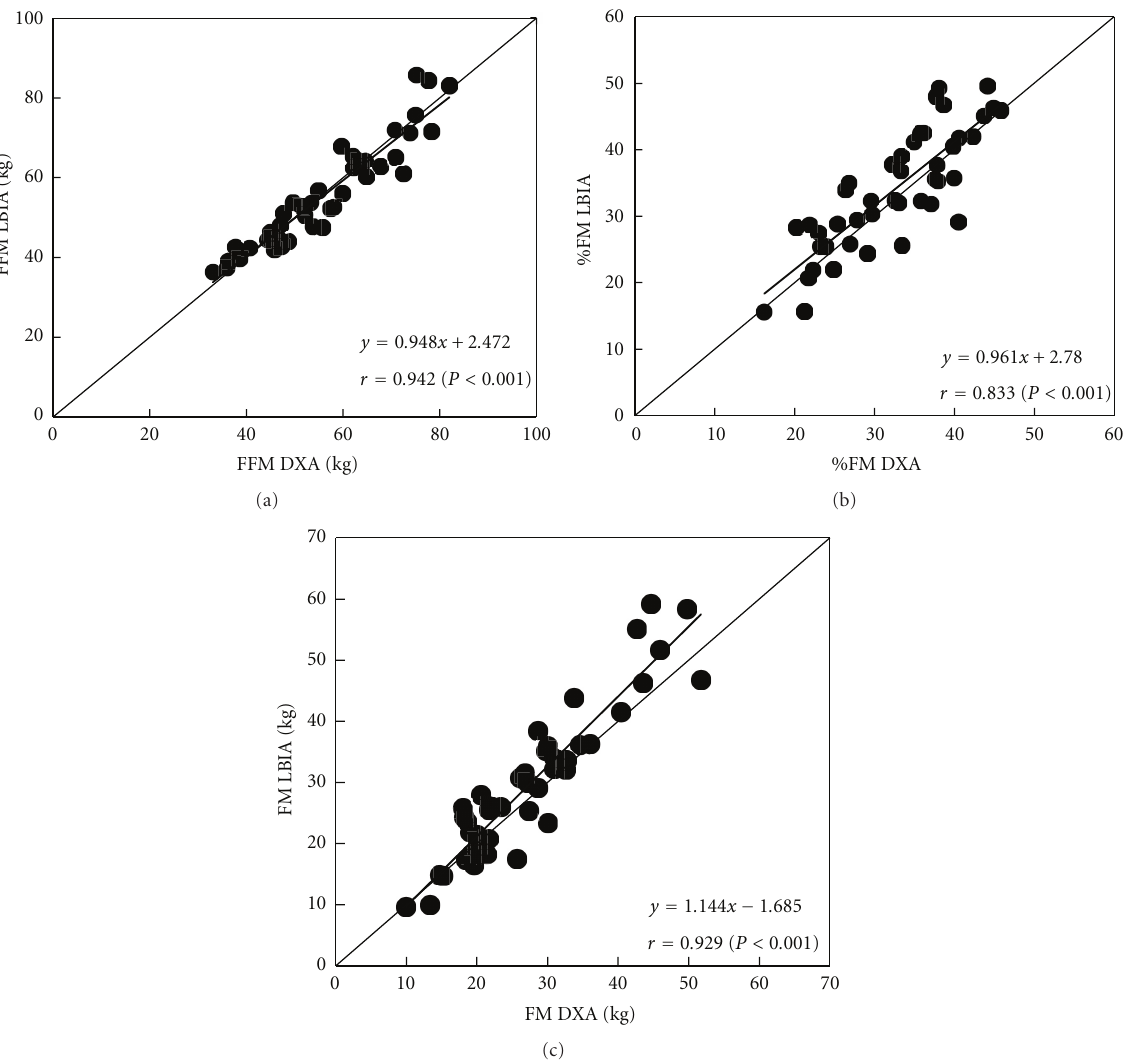
Figure 1: Regressions between the FFM (a), %FM (b), and FM (c) assessed by LBIA and that assessed by DXA (before intervention) DXA: dual X-ray absorptiometry; LBIA: leg-to-leg bioelectrical impedance analysis; FFM: fat free mass; %FM: percentage body fat; FM: fat mass. Solid lines regression lines, dotted lines of